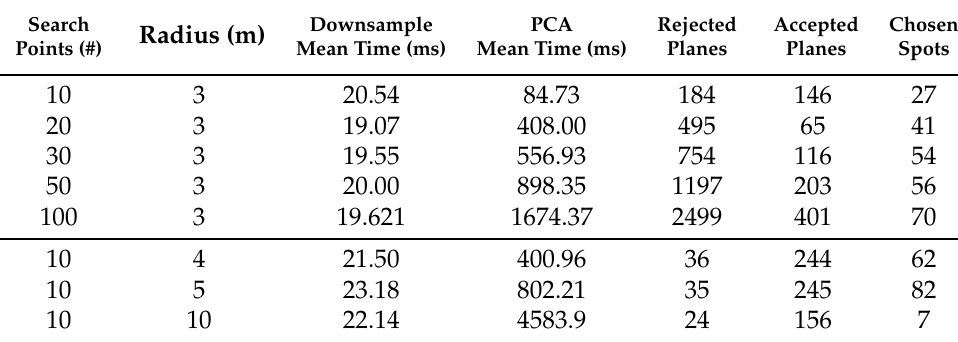
Table 3. Results for the simulation of the first case.